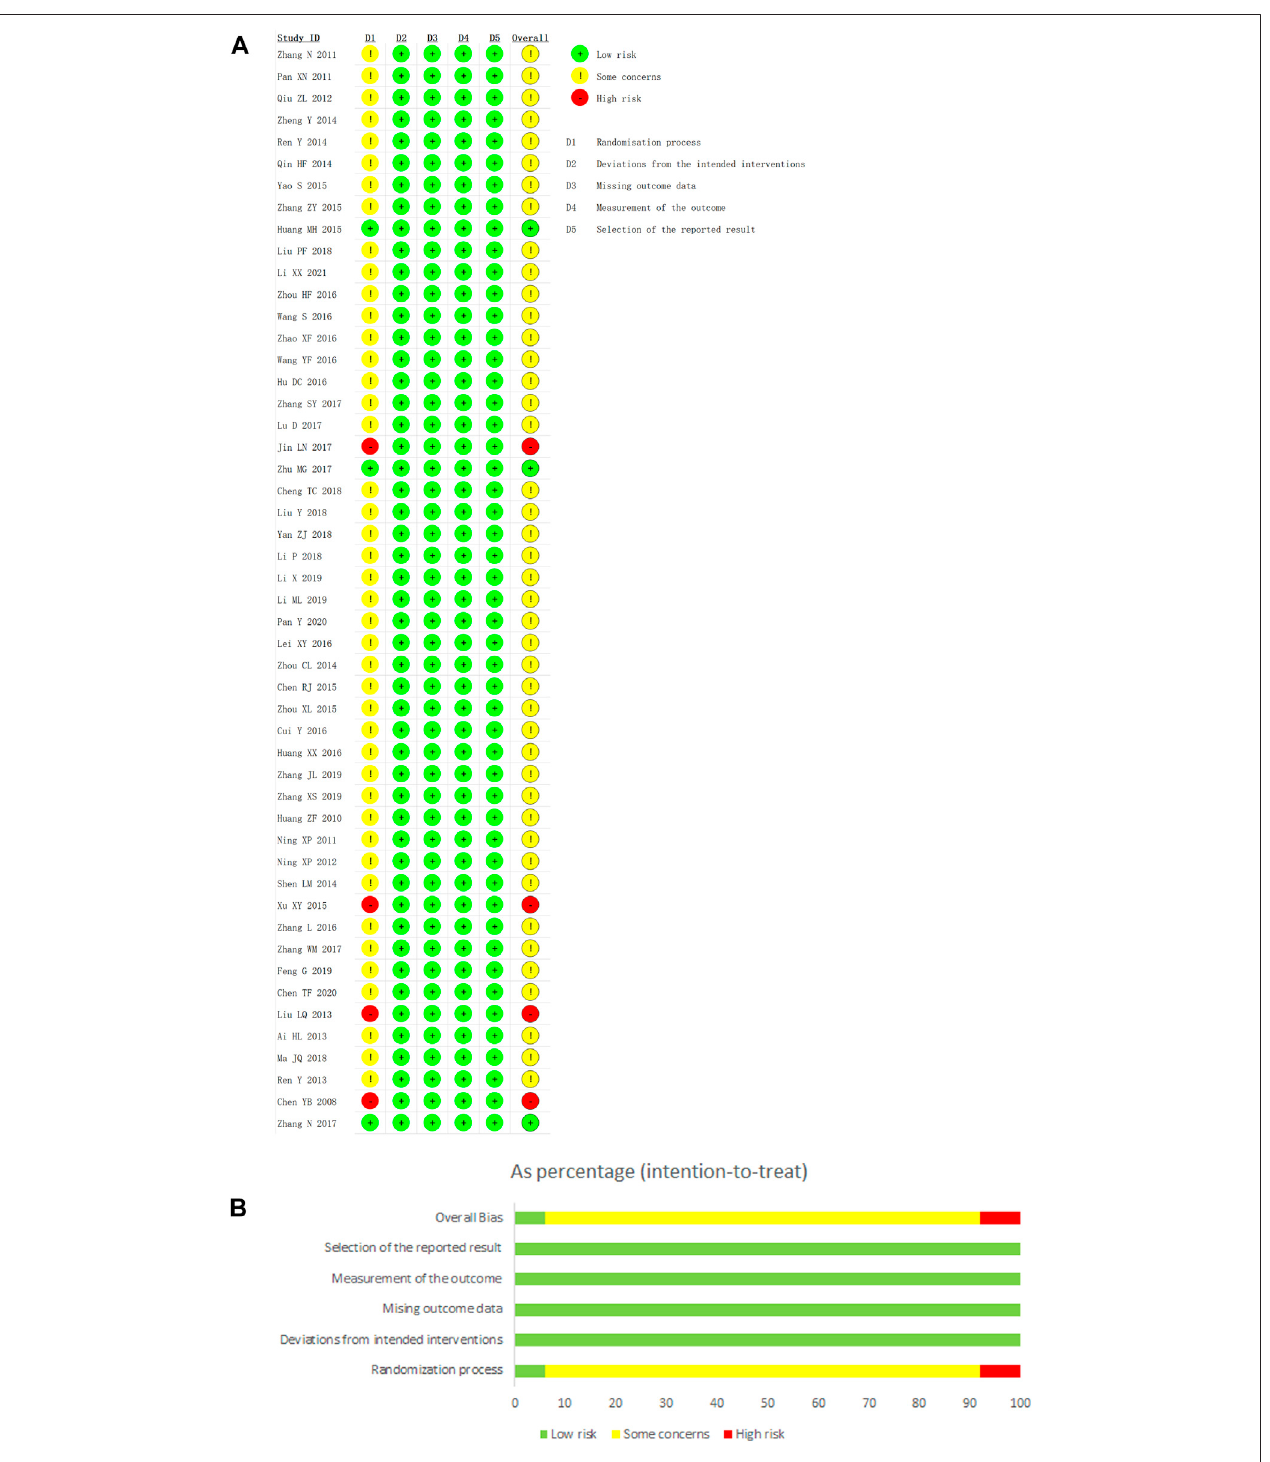
FIGURE 3 | Risk of bias graph. Note: (A) : Risk of bias graph; (B) : Risk of bias summary.